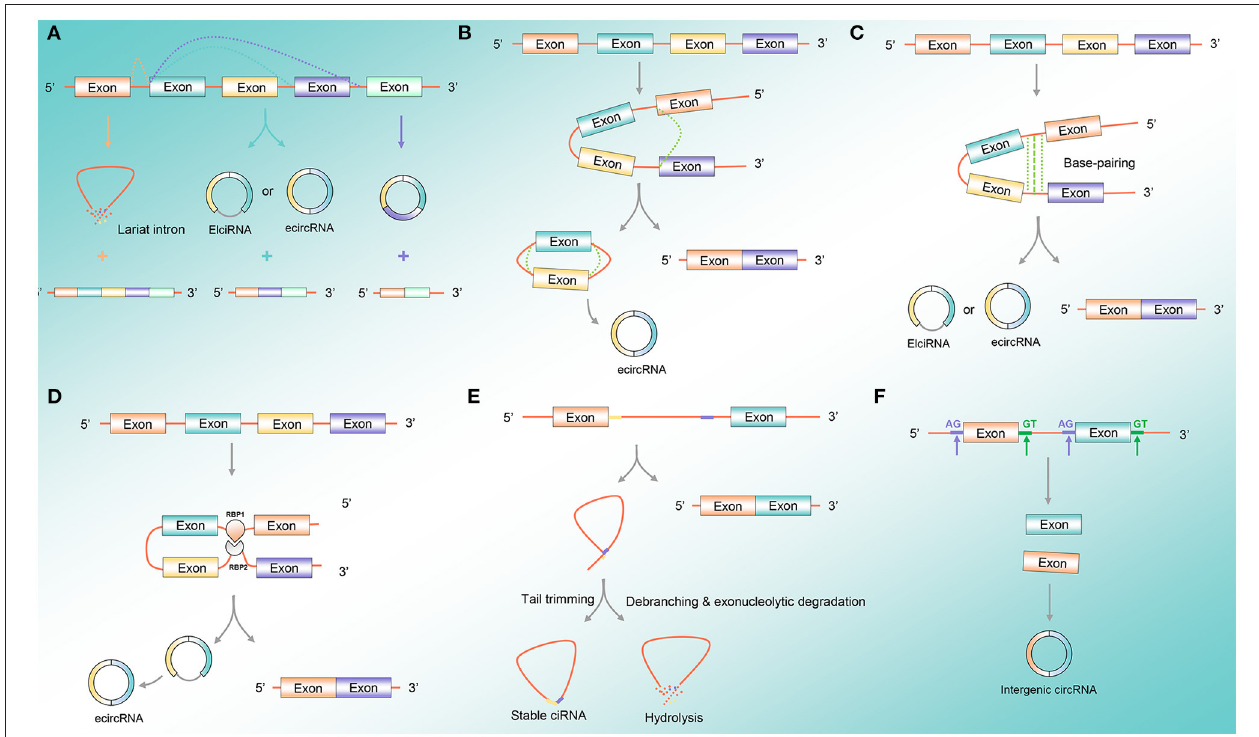
FIGURE 1 | CircRNA formation pattern. (A) Variable cyclization mode: circRNA formation is a variable cyclization mode to generate different types of circRNAs according to different splice sites. (B) Exon skipping: the pre-mRNA is partially folded during the transcription process, so that the 3 ′ -SD of the downstream exon is connected to the 5 ′ -SA of the upstream exon, causing the exon to skip and form an RNA lariat containing both exons and introns. (C) Direct back-splicing: direct back-splicing is the main form of ecircRNA and EIciRNA production, where the flanking intron complementary sequences of pre-mRNAs form a lasso by direct base pairing. (D) RBP-dependent circRNA formation: RBPs bind to the sequence motifs of upstream and downstream in introns on both sides of the exon and act as the bridge to draw the distance between the flanking introns to form circRNA. (E) CiRNA formation pattern: the pre-mRNA can be spliced into an RNA lasso containing a 2 ′ ,5 ′ -phosphodiester, resulted in the formation of ciRNAs after cutting off the 3 ′ -tail. (F) Intergenic circRNA formation pattern: the circRNA contains two intronic circRNA fragments flanked by GT-AG splicing signals, acting as the splice donor and splice acceptor of the circular junction to finally form an intergenic circRNA. Abbreviations: circRNA, circular RNA; ecircRNA, exonic circRNA; EIciRNA, exon-intronic circRNA; RBP, RNA-binding protein; ciRNA, circular intronic